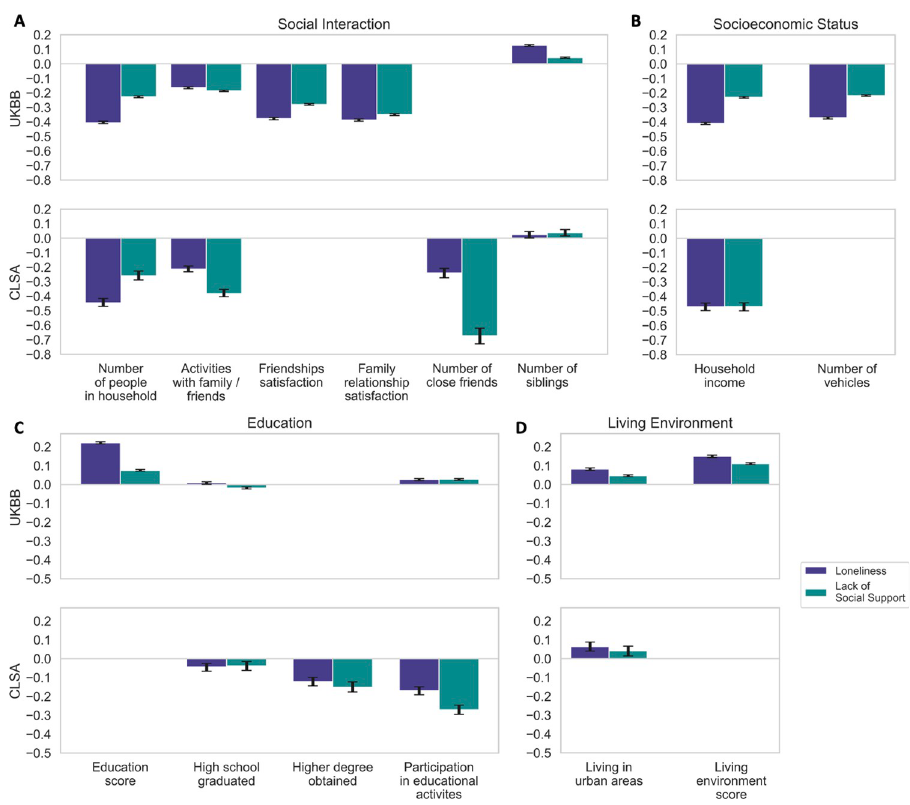
Fig 5. Societal risk factors exhibit salient association effects with social isolation. Bayesian estimation of the posterior probability that a given risk factor relates to one of two measures of social deprivation: loneliness and lack of social support. All societal risk factor variables were z-scored prior to running the Bayesian models. For simplicity, results are expressed as the mean and the 90% highest posterior density interval for the model coefficients (black error bars). In the UKBB and the CLSA datasets, loneliness and lack of social support show strong associations with several societal factors, including (A) the number of people living in the household and the number of close friends, (B) household income, and (C) graduating from high school and obtaining higher degrees. (D) Living in an urban environment is also linked with higher levels of subjective and objective social deprivation.